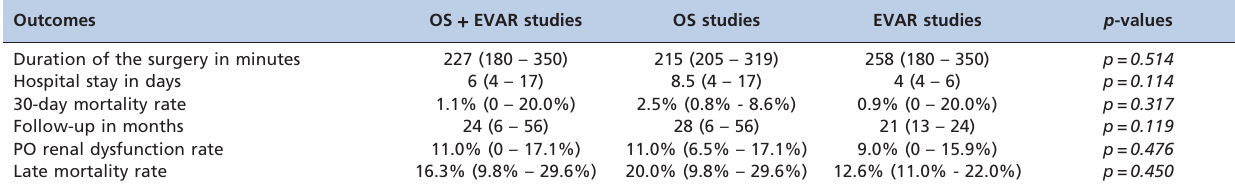
Table 3 - Analysis of the median data regarding the outcomes reported in studies on open surgery and endovascular repair of short-necked juxtarenal aortic abdominal